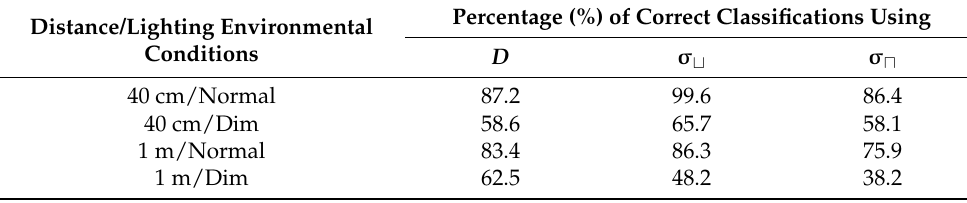
Table 2. Results by the GbCvector classifier with concatenated vectors r and ϕ for four different environmental conditions.